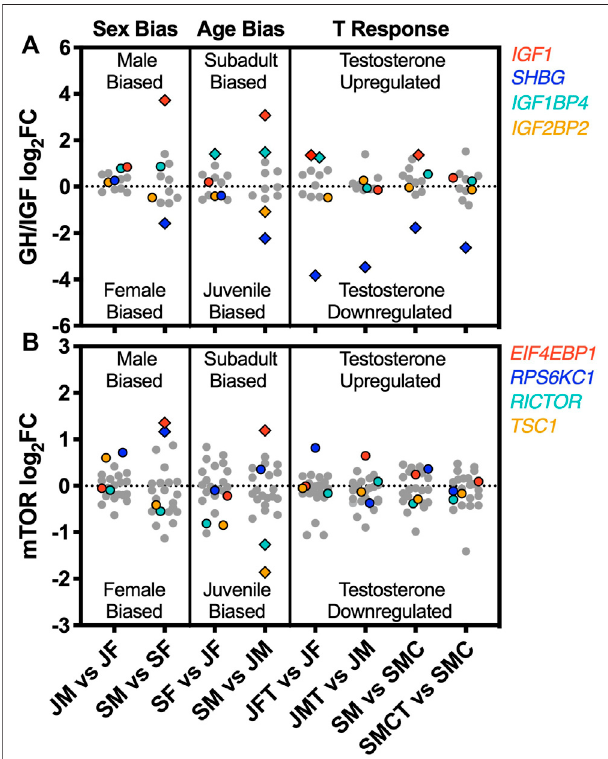
FIGURE 5 | Sex bias, age bias, and responsiveness to testosterone for genes in two growth-regulatory pathways. Log 2 (FC) values for genes in the (A) growth hormone/insulin-like growth factor (GH/IGF) and (B) mechanistic target of rapamycin (mTOR) signaling pathways, shown separately for each ofeight experimental comparisonsillustratingsexbias(juvenilemalesvs. juvenile females, JM vs. JF; subadult males vs. subadult females, SM vs. SF), age bias (subadult females vs. juvenile females, SF vs. JF; subadult males vs. juvenile males, SM vs. JM), and responsiveness to testosterone (juvenile females with and without testosterone: JFT vs. JF; juvenile males with and without testosterone, JMT vs. JM; intact subadult males vs. castrated subadult males, SM vs. SMC; castrated subadult males with and without testosterone,SMCTvs.SMC).Coloredsymbols represent genesdetected as a signi fi cant DEG in at least one of the 8 contrasts. Diamond symbols represent genes detected as DEGs within a particular contrast. Grey symbols were not signi fi cantly differentially expressed in any